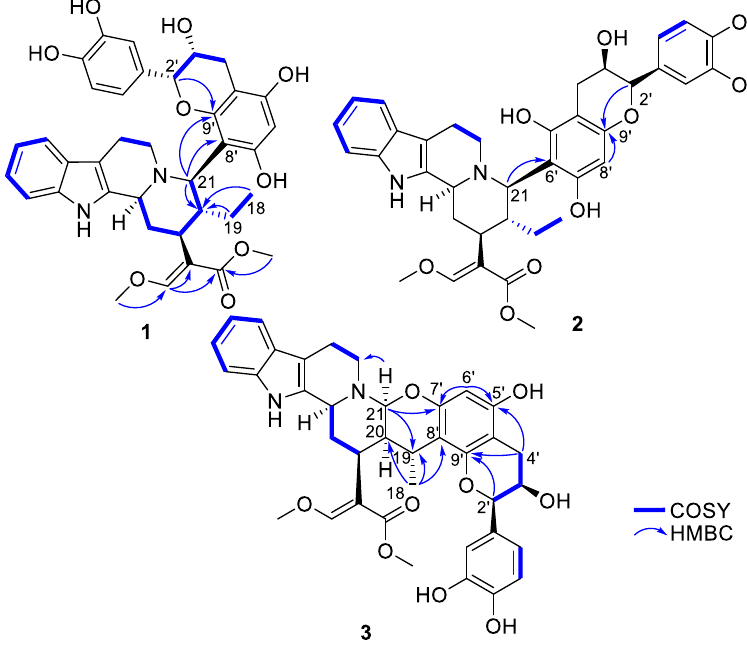
Figure 2. Key COSY and HMBC correlations of compounds 1 – 3 .